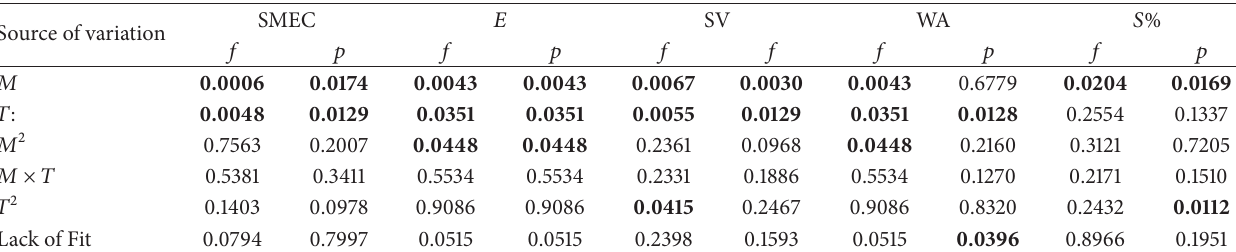
Table 3: Degrees of significance ( 𝑃 value) of each term of the regression model (source of variation), corresponding to each response and for the two rice varieties.